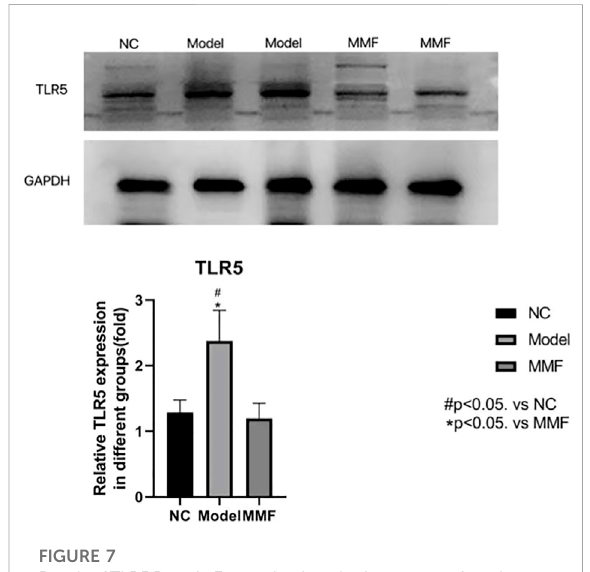
FIGURE 7 ResultofTLR5ProteinExpressionincolonicmucosaofratsin each